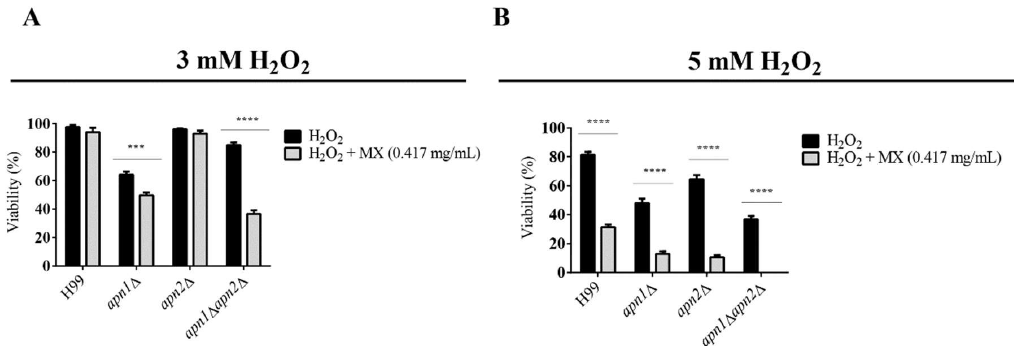
Figure 5. Methoxy-amine (MX) enhances the effects of H 2 O 2 on the viability of the C . neoformans apn 1 ∆ apn 2 ∆ mutant strain yeasts. Cell survival of C . neoformans WT and mutant strains for the combined exposure to MX and H 2 O 2 Strains were cultured in liquid YPD containing 0.417 mg/mL MX and ( A ) 3 or ( B ) 5 mM H 2 O 2 , for 1 h, at 30 °C and 150 rpm. Cells incubated only in YPD containing 3 or 5 mM H 2 O 2 were used as comparison. The graph represents the percent of survival of each strain exposed to each condition described compared to the control condition (YPD medium). Two-way ANOVA with Sidak’s multiple-comparisons test was used to compare the means of results from three independent experiments. Error bars represent standard errors of the mean. **** p < 0.0001; *** p < 0.001.